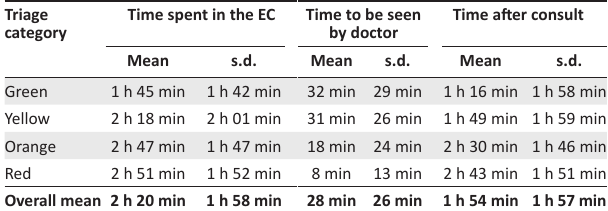
TABLE 5: Mean times spent in the emergency centre per triage category (with standard deviations) in a private hospital in South Africa in 2018.